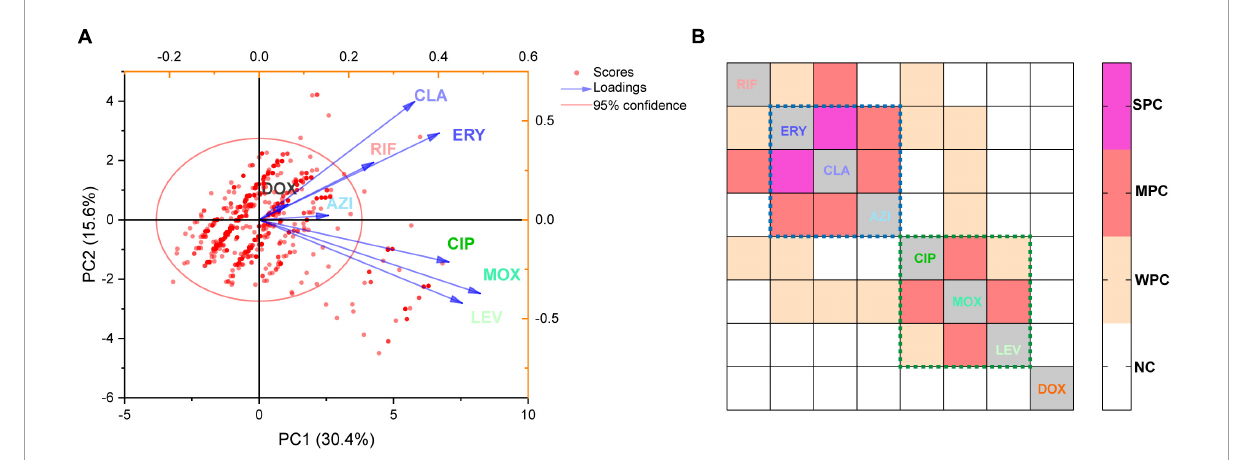
FIGURE3 Principal component analysis and correlation matrices for the minimum inhibitory concentrations (MICs) were obtained from 1464 L. pneumophila isolates. (A) PCA of indices of the isolates. Isolates are shown as dots and colored red. Indices are shown as lines with arrows and colored. The configuration of indices in the plot represented the relationship between variables and principal components. (B) Correlation matrix for isolates’ indices (MICs). WPC, weak positive correlation, 0.2 < r ≤ 0.3; MPC, moderate positive correlation, 0.3 < r ≤ 0.5; SPC, strong positive correlation, r > 0.5. NC, no correlation. The largest r was found between CLA and ERY ( r = 0.51). The dotted lines indicate that these antibiotics (in the dotted lines with the same color) belong to the same class.